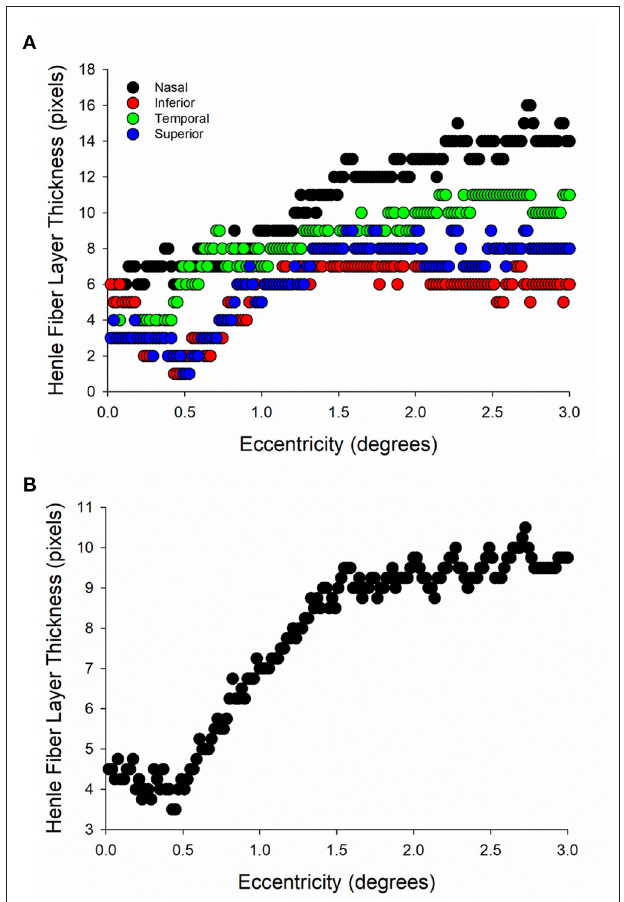
were not normally distributed, a Mann-Whitney Rank Sum Test ( α = 0.05) compared the thickness between the two